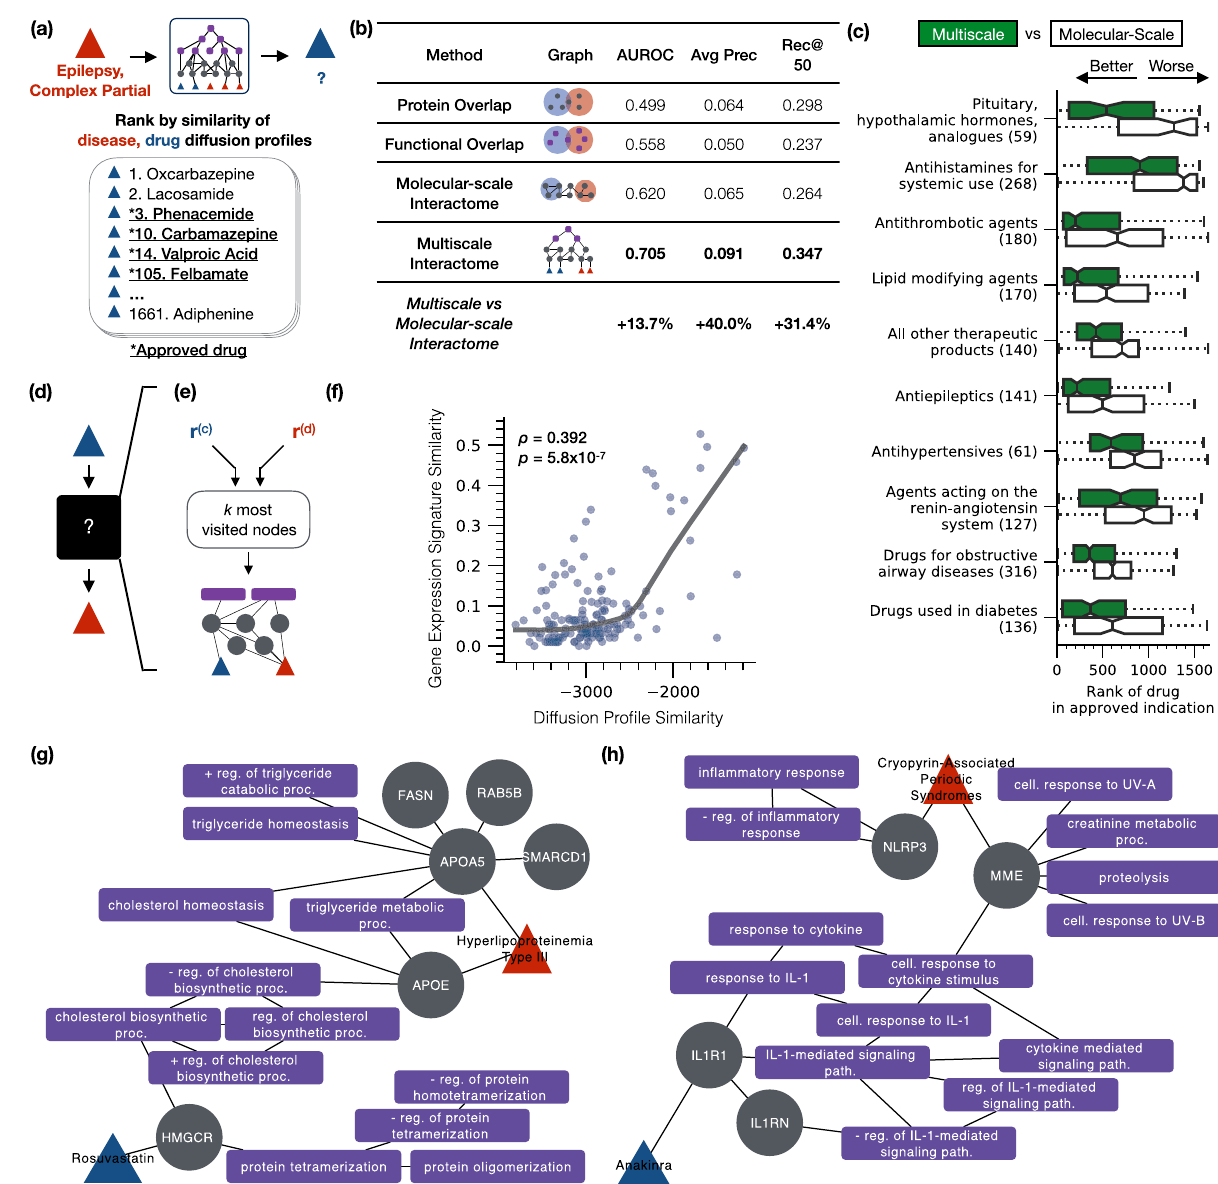
Fig. 2 The multiscale interactome accurately predicts what drugs treat a disease and systematically identi fi es proteins and biological functions related to treatment. a To predict whether a drug treats a disease, we compare the drug and disease diffusion pro fi les according to a correlation distance. b By incorporating both proteins and biological functions, the multiscale interactome improves predictions of what drug will treat a given disease by up to 40% over molecular-scale interactome approaches 13 . Reported values are averaged across fi ve-fold cross validation (see the “ Methods ” section); multiscale interactome values are in bold. c The multiscale interactome outperforms the molecular-scale interactome most greatly on drug classes known to harness biological functions that describe processes across the body (i.e., pituitary, hypothalamic hormones and analogs). d Existing interactome approaches are black boxes: they predict what drug treats a disease but do not explain how the drug treats the disease through speci fi c biological functions 10 – 15 . e By contrast, the drug and disease diffusion pro fi les ( r ( c ) and r ( d ) ) reveal the proteins and biological functions relevant to treatment. For each drug and disease pair, we induce a subgraph on the k most frequently visited nodes in the drug and disease diffusion pro fi les to explain treatment. f Drugs with more similar diffusion pro fi les have more similar gene expression signatures (Spearman ρ = 0.392, p = 5.8 × 10 − 7 , n = 152, two-sided), suggesting that drug diffusion pro fi les capture their biological effects. g The multiscale interactome explains treatments that molecular-scale interactome approaches cannot faithfully represent. Rosuvastatin treats Hyperlipoproteinemia Type III by binding to HMG CoA reductase (HMGCR) which drives a series of cholesterol biosynthetic functions affected by Hyperlipoproteinemia Type III 50 – 56 . h Anakinra treats cryopyrin-associated periodic syndromes (CAPS) by binding to IL1R1 which regulates immune-mediated in fl ammation through the Interleukin-1 beta signaling pathway 30,58 . In fl ammation is a hallmark of CAPS 57 . Abbreviations: reg. regulation, path. pathway, proc. process, cell. cellular, + positive, − negative. Boxplots: median (line); 95% CI (notches); 1st, 3rd quartiles (boxes); data within 1.5 × the inter-quartile range from the 1st, 3rd quartiles (whiskers). Sample sizes in parentheses.